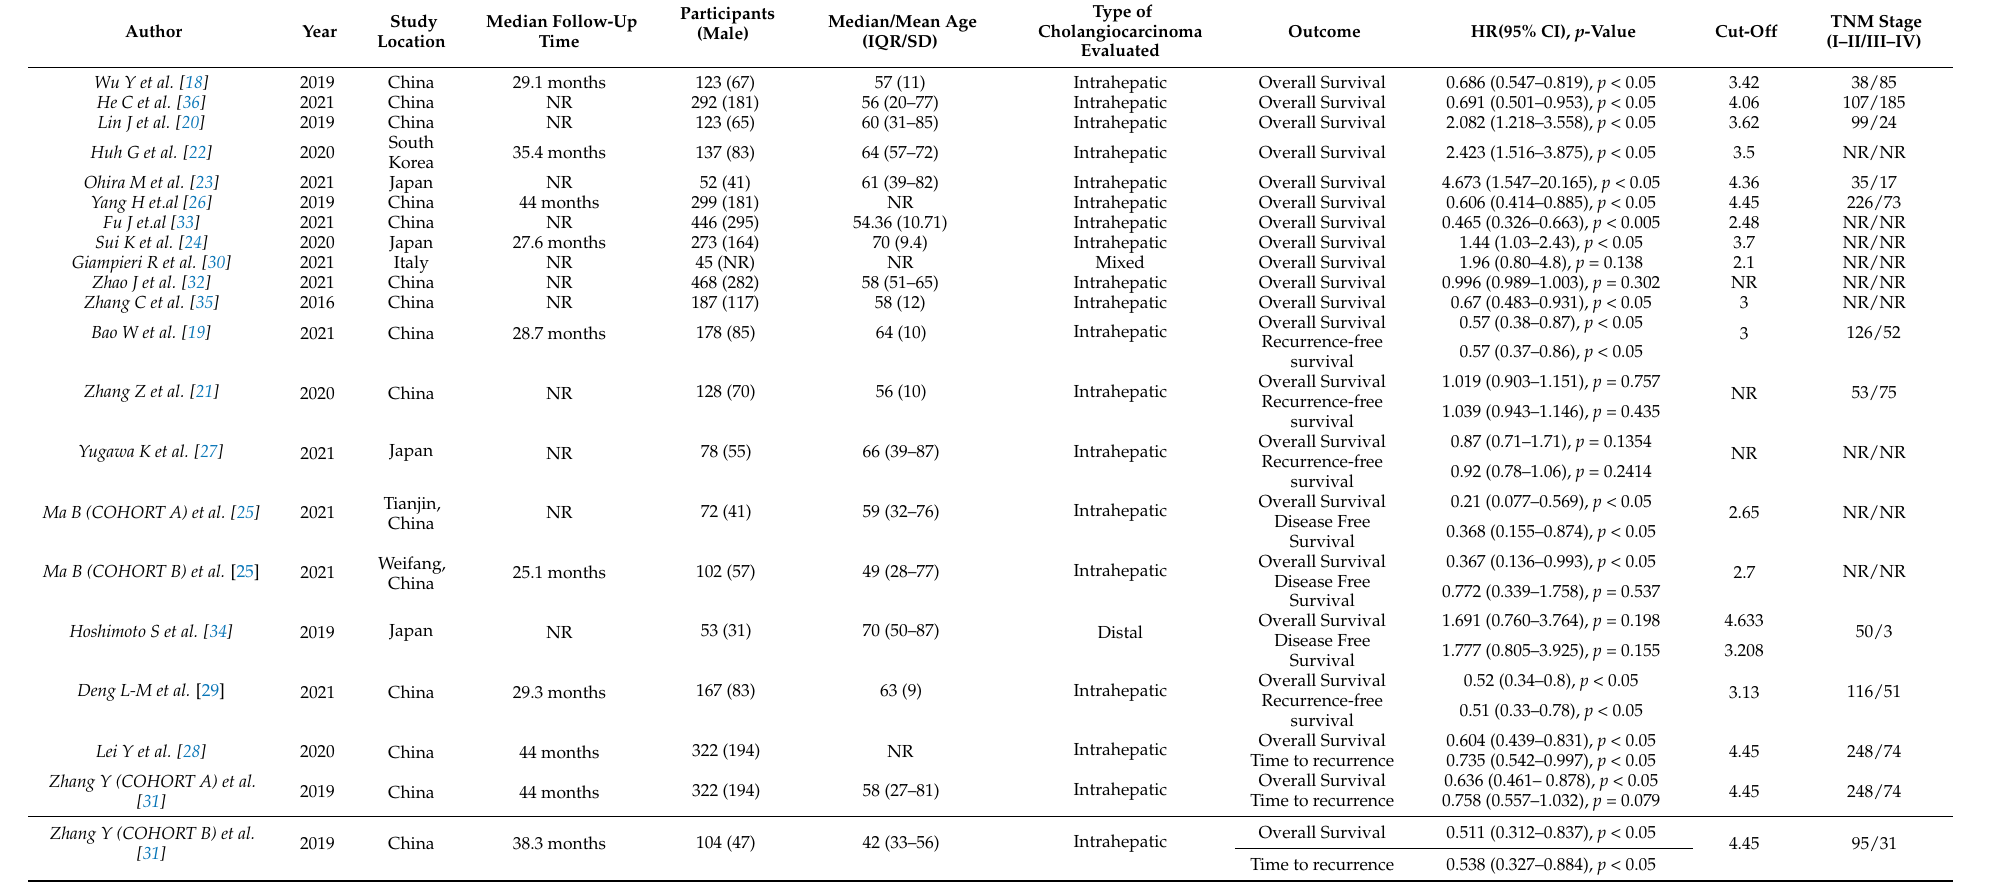
Table 1. Characteristics of the included